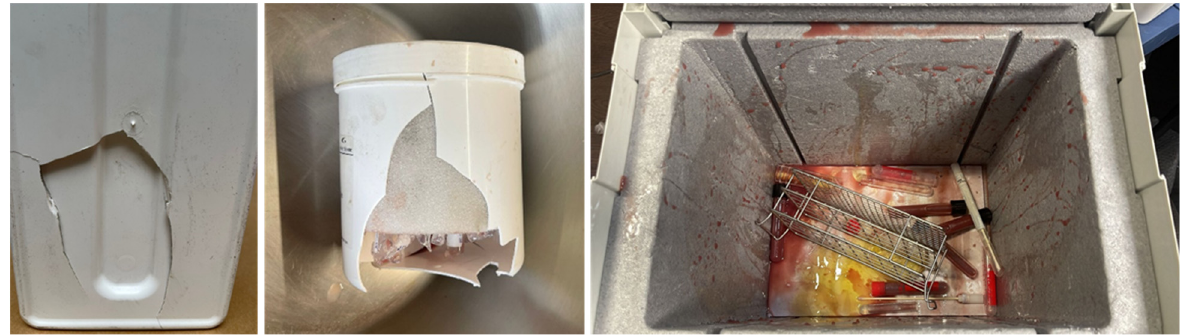
Figure 5. Leaks and breakage of containers in the transport of infectious samples.